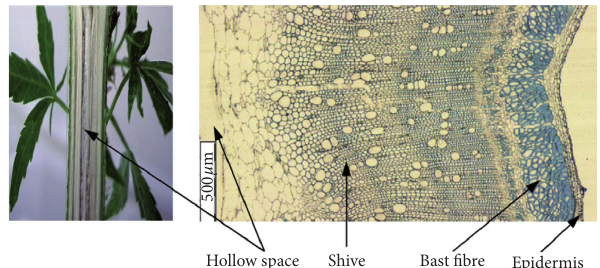
Figure 3: Cross section of the hemp stem and location of the bast fibre [30].